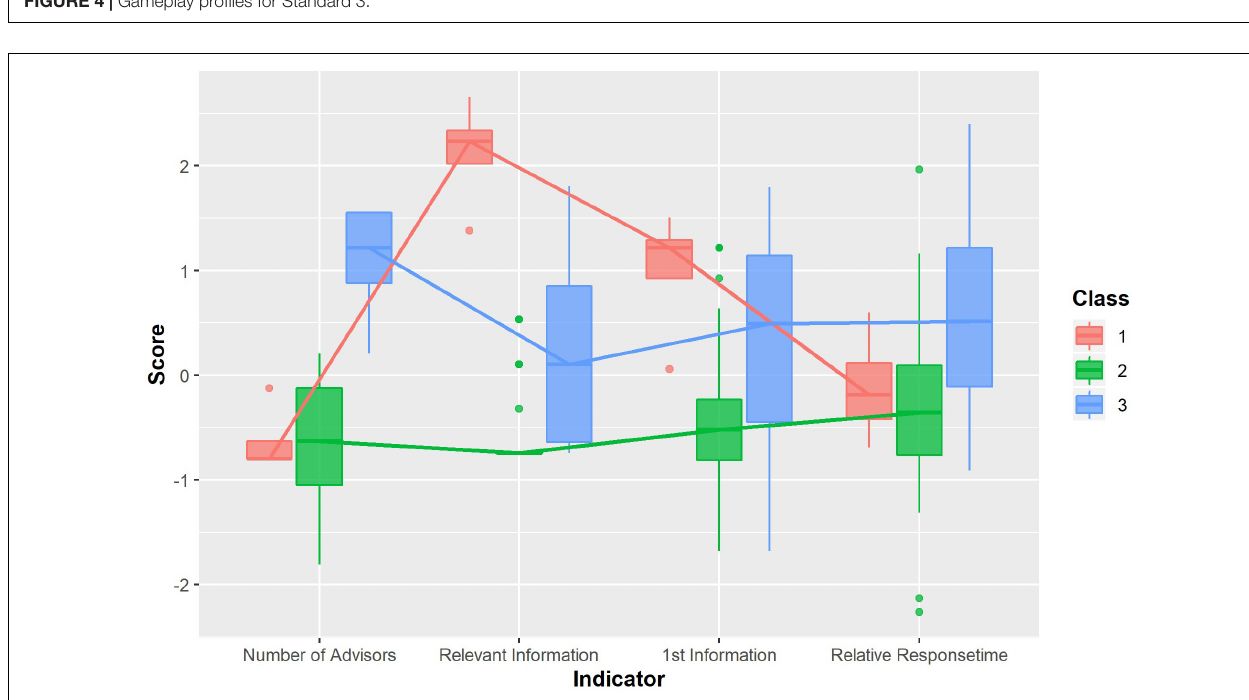
FIGURE 4 | Gameplay profiles for Standard 3.